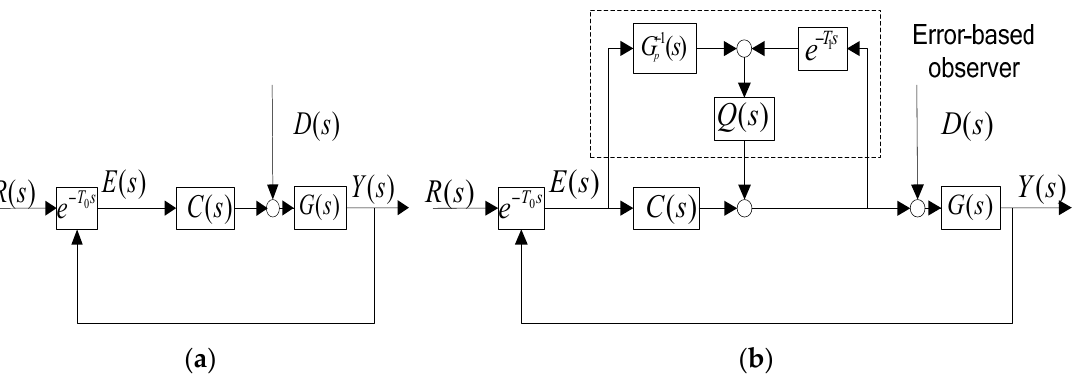
Figure 2. The control mode. ( a ) The traditional control mode; ( b ) the error-based observer (EBO) control mode.